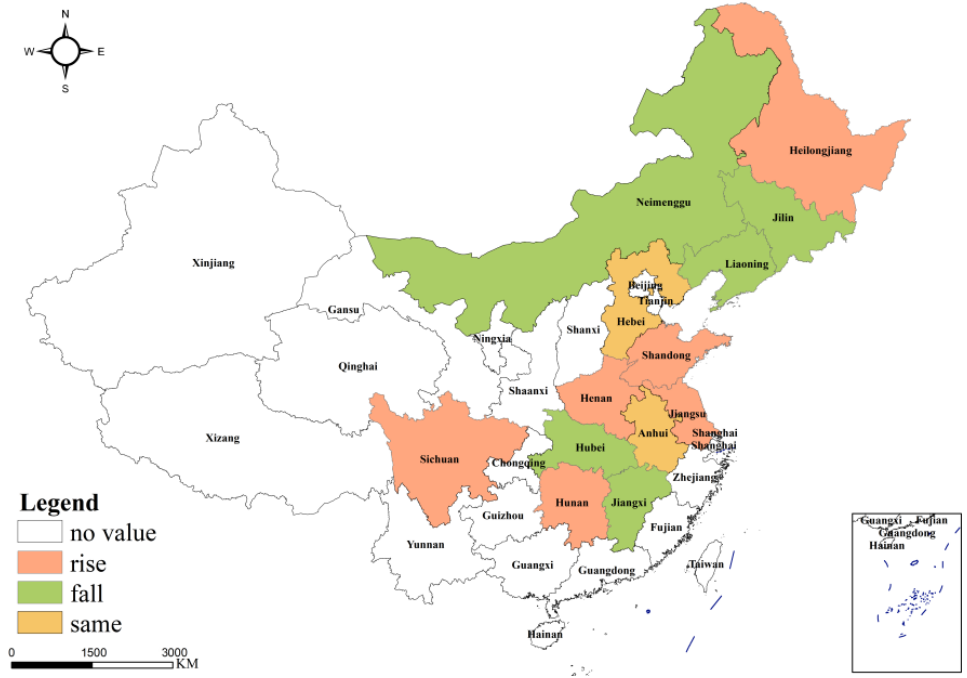
Figure 3. The ranking changes in grain production resource allocation efficiency (comprehensive technical efficiency) in the main grain-producing areas in China after adjustment.